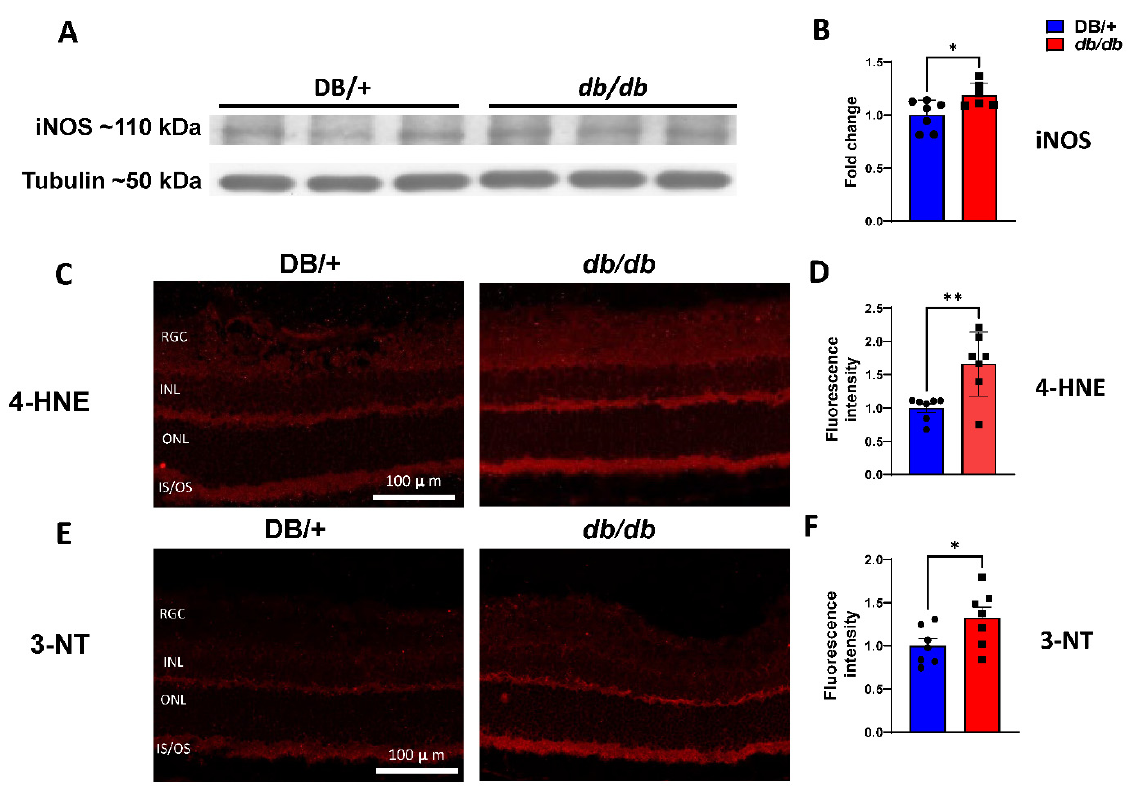
Figure 3. Increased oxidative/nitrative stress in the retinas of db/db mice. ( A ) Representative Western blots with ( B ) quantification expressed as fold changes from the control, showing elevated iNOS levels in db/db retinal protein lysate compared with the lean DB/+ controls (n = 6–7/genotype) (* p < 0.05). ( C , E ) Immunofluorescent labeling at 10× of frozen retina sections with 4-hydroxynonenal (4-HNE) and 3-nitrotyrosine (3-NT). ( D , F ) Fluorescence intensity quantification of 4-HNE and 3-NT, respectively (n = 7/genotype). Data are presented as the mean ± SEM. (* p < 0.05, ** p < 0.01). RGC: retinal ganglion cell layer; INL: inner nuclear layer; ONL: outer nuclear layer; IS/OS: inner/outer segment of photoreceptor.